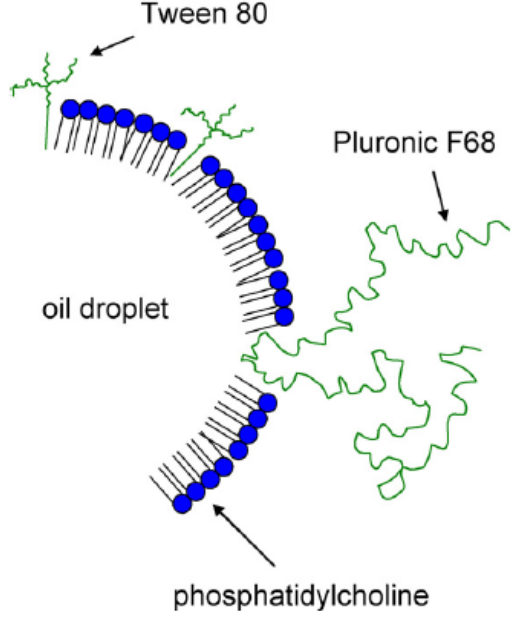
Figure 2. Schematic of oil droplet emulsified by various surfactants in aqueous bulk phase. Figure taken with permission from reference